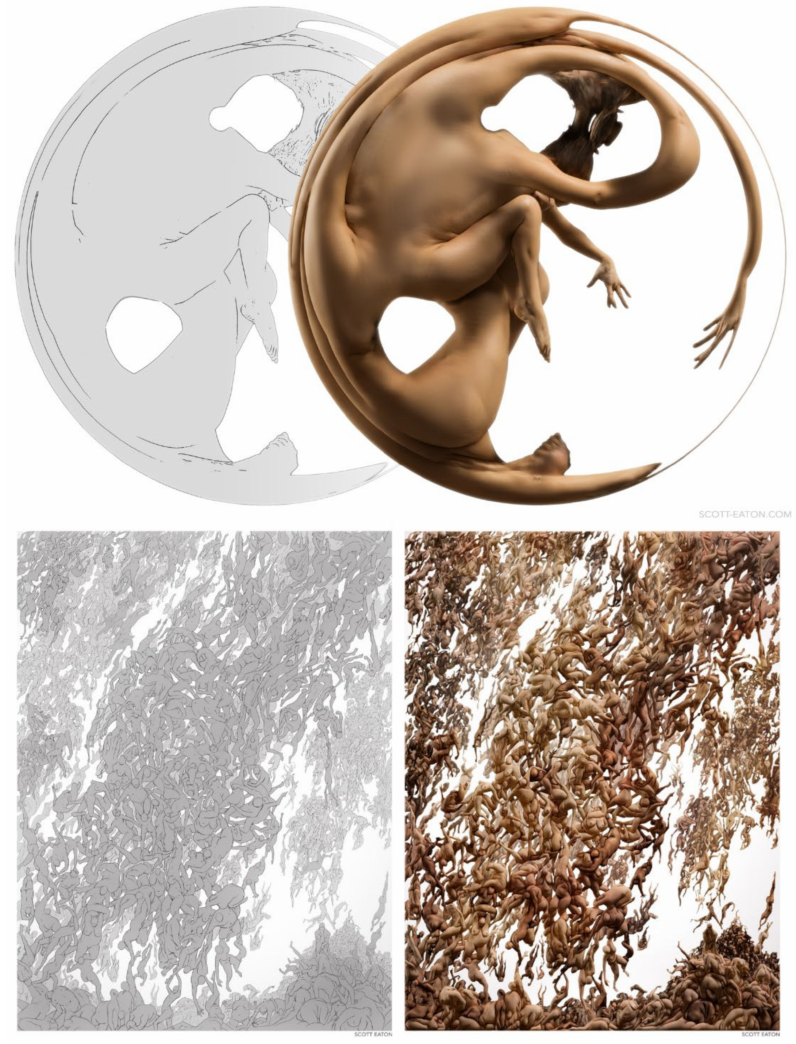
Figure 24. Artist, Creative AI (Artificial Intelligence)